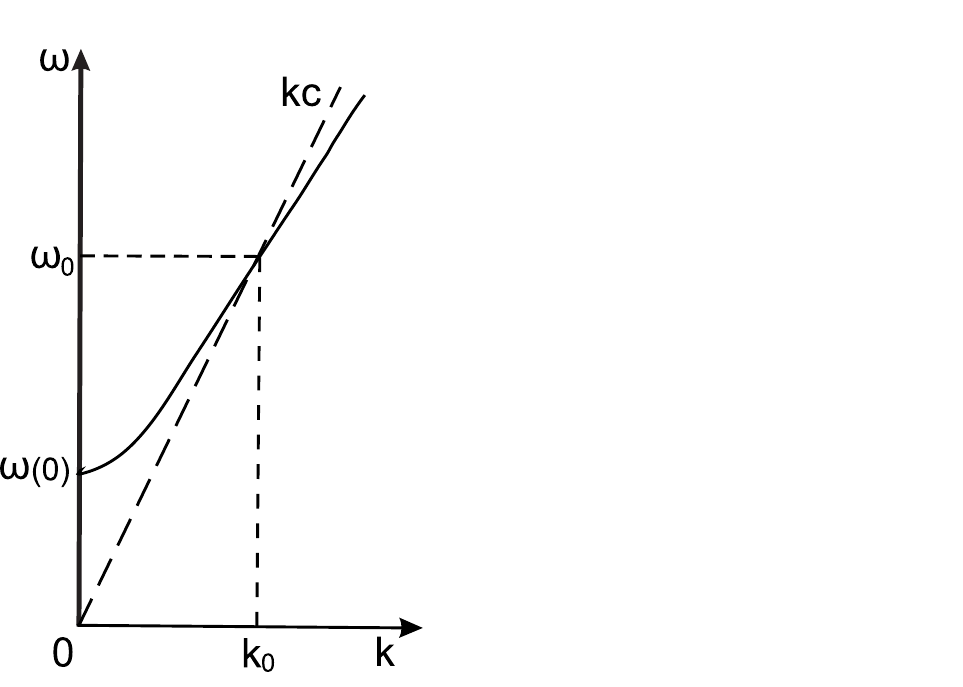
Figure 2. Wave number dependence of the frequency of Langmuir waves in the case of an ultra- relativistic plasma (here ω ( 0 ) ≡ ω k = 0 ∼ ω p (cid:104) γ (cid:105) − 1/2 ; Lominadze et al.